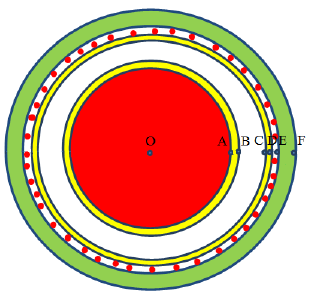
Figure 1. A standard structure of high-voltage cables consisting of six layers. Different installation environments are considered in real world